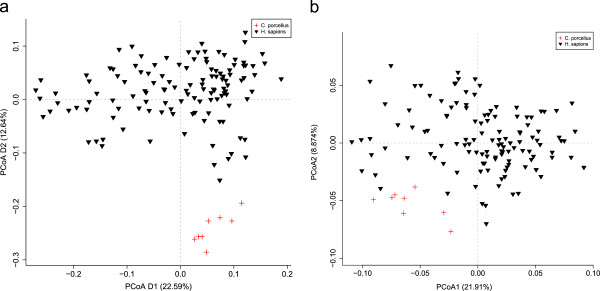
Bray-Curtis distances between samples. PCoA (Principle Coordinates Analysis) of Bray-Curtis distances between samples for (a) genus and (b) KO. A similar separation as shown for the genera was seen on all other taxonomic levels.